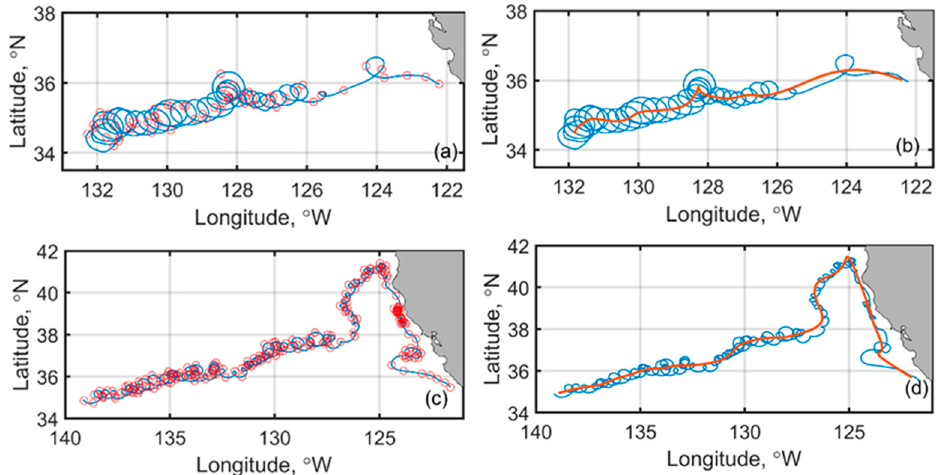
Figure 7. Approximation of observed RAFOS trajectories for floats #73 ( a ) and #109 ( b ) by Daubichies wavelet of the 10th order and comparison of the mean Lagrangian trajectories with the observed data (float #73 ( c ) and float #109 ( d )). Red curves and red dots are the mean Lagrangian trajectories and trajectories reconstructed by wavelets, respectively. Blue curves are the observed data.